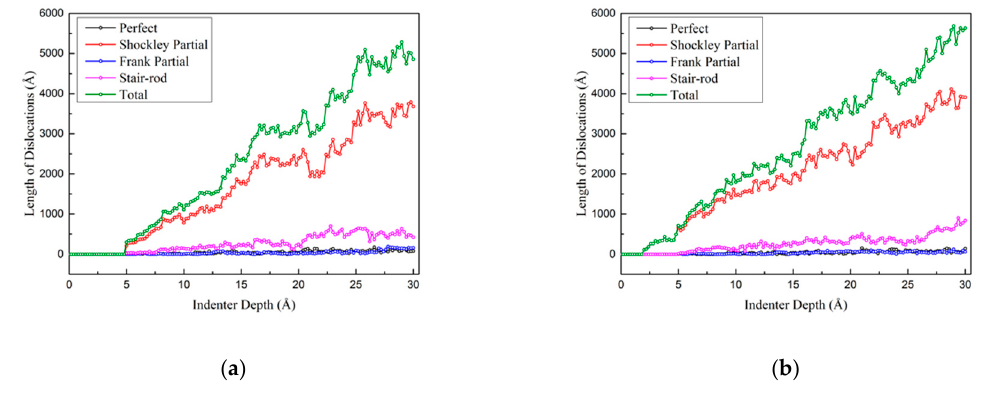
Figure 11. The formation of twinning partial slips on the lower twin boundaries in three different models. ( a ) TPT, d = 26.8 Å; ( b ) SDT, d = 22.4 Å; ( c ) TDT, d = 16.6